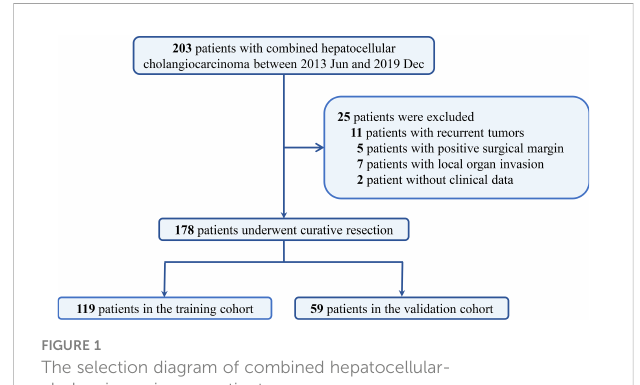
FIGURE 1 The selection diagram of combined hepatocellular- cholangiocarcinoma